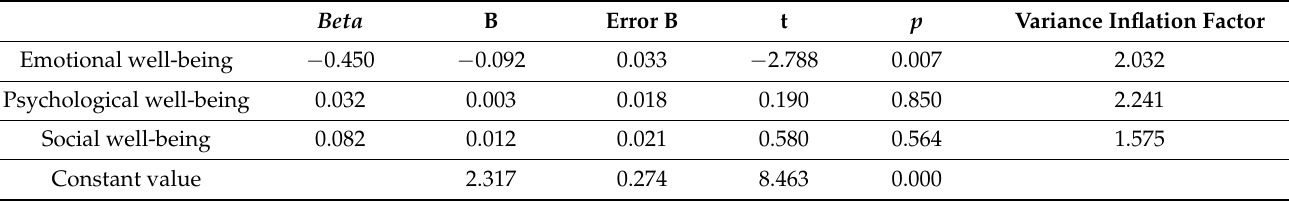
Table 10. PTSD predictors (individuals with depression) ( n = 70 in each group).